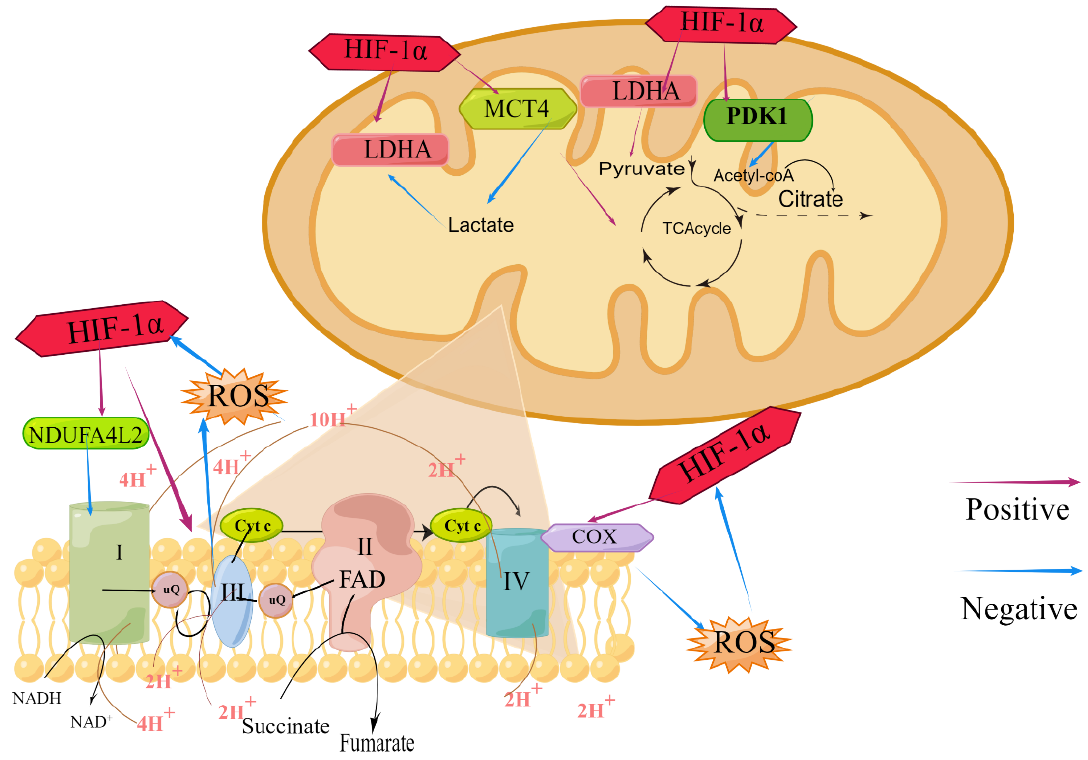
Figure 2. The effects of HIF-1 on TCA cycle, electron respiratory chain and ROS production in mitochondrial function.